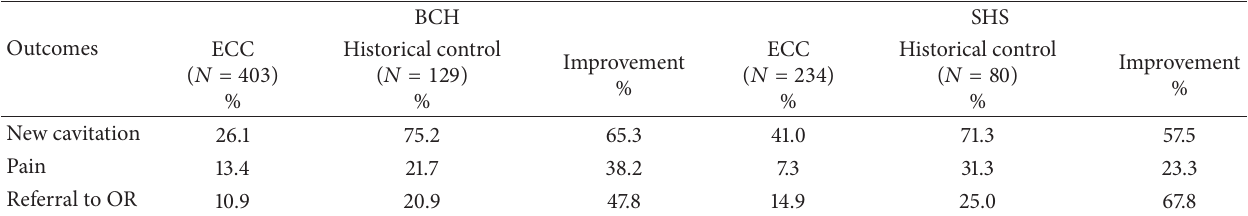
Table 1: ECC Phase 1: comparison of rates of new cavitation, pain, and referral to OR between ECC patients and historical